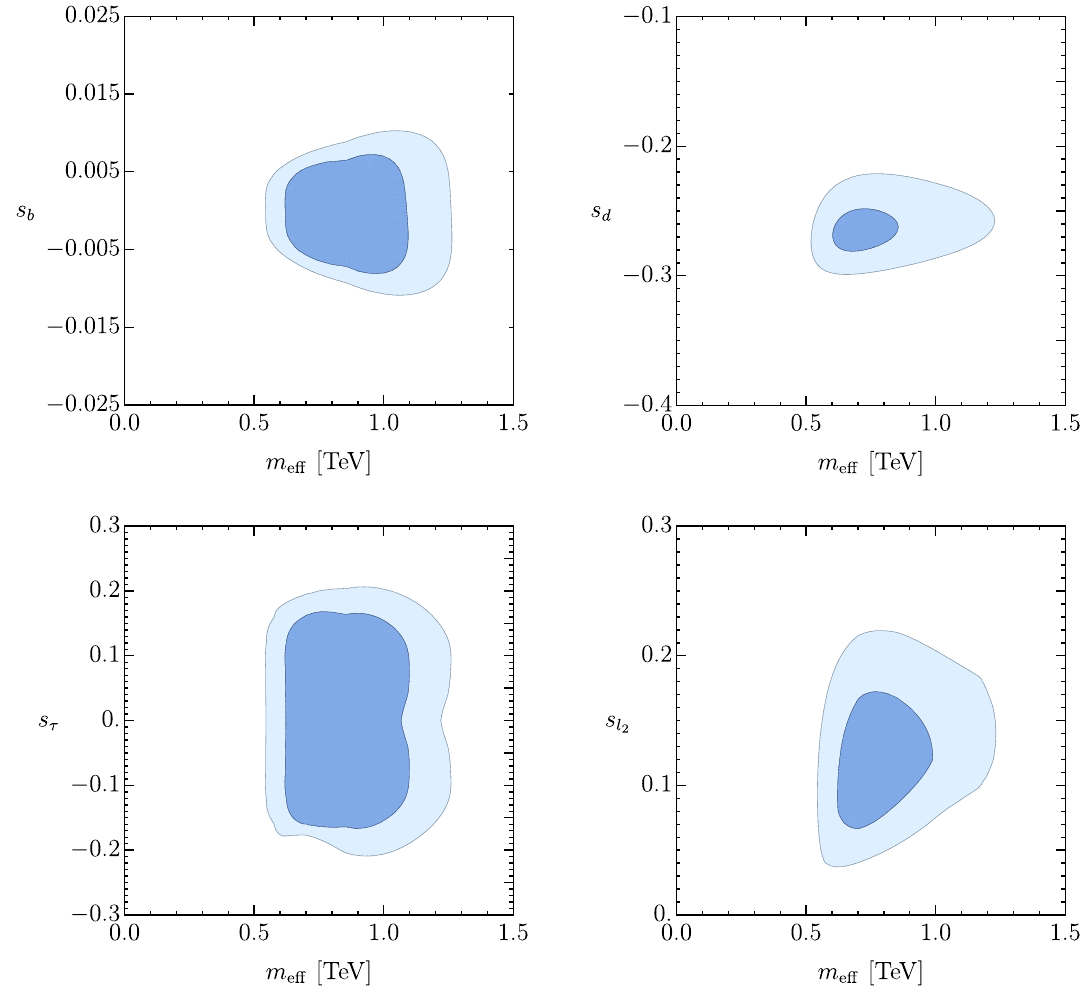
Fig. 3 Two-dimensional preferred 1 and 2 σ regions (in blue and light blue, respectively) for m eff vs s b , s d , s τ , s l